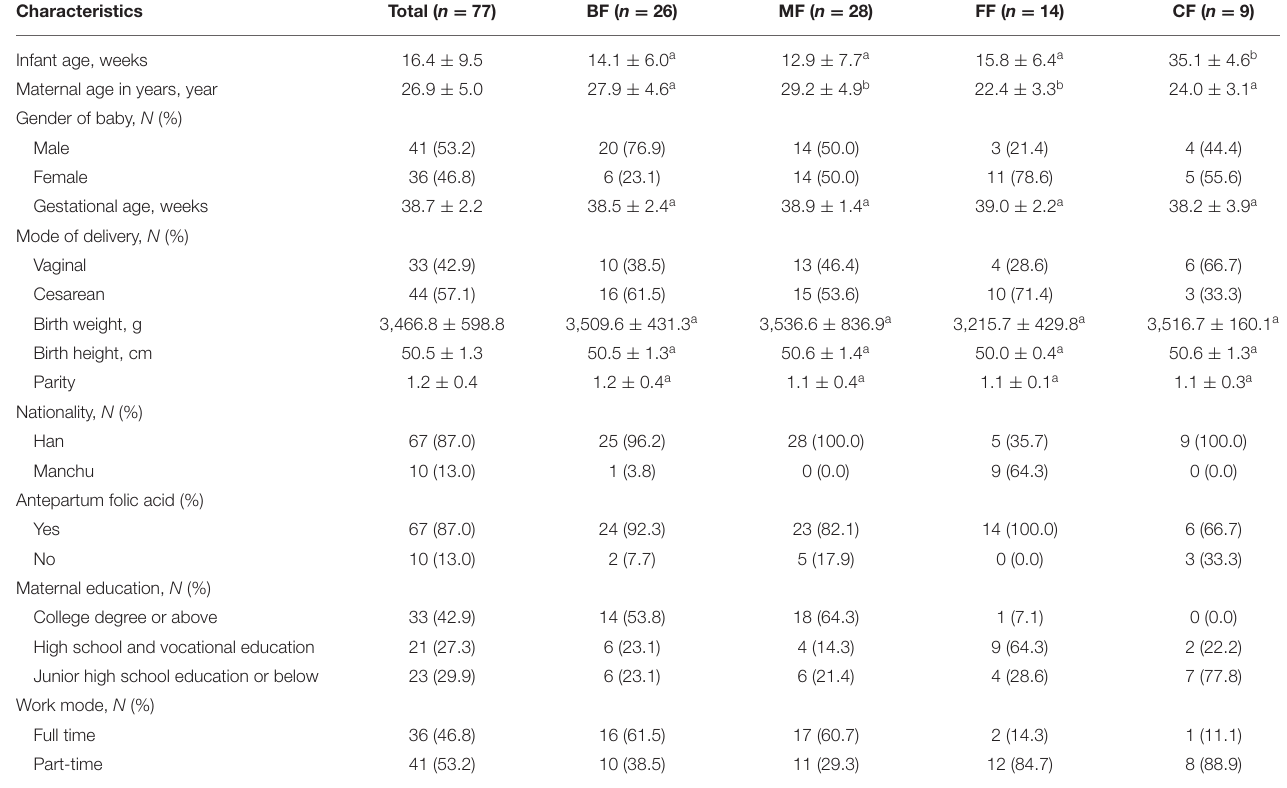
“ ± ” indicates standard deviation from mean where applicable. Different lowercase letters in the same line indicate significant difference (p < 0.05). Statistical analysis between infants who fed with breast milk (BF), formula (FF), breast milk and formula (MF), or complementary food (CF) was determined using one-way analysis of variance (ANOVA, SPSS 17.0) followed by multiple comparisons with Duncan’s multiple range